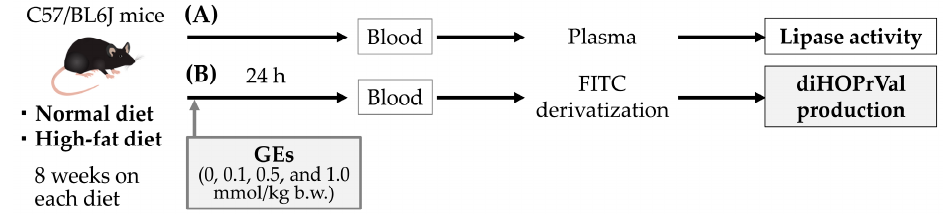
Figure 2. Procedures for animal experiments. ( A ) Lipase activity in plasma was measured in five normal diet and five high-fat diet groups. ( B ) Five normal diet and five high-fat diet groups were treated with 0, 0.1, 0.5, and 1.0 mg/kg b.w. of glycidyl fatty acid esters (GEs). Twenty-four hours after GEs administration, blood was drawn. After solid-phase extraction of blood samples, blood was derivatized using fluorescein isothiocyanate (FITC), and then diHOPrVal levels were measured by